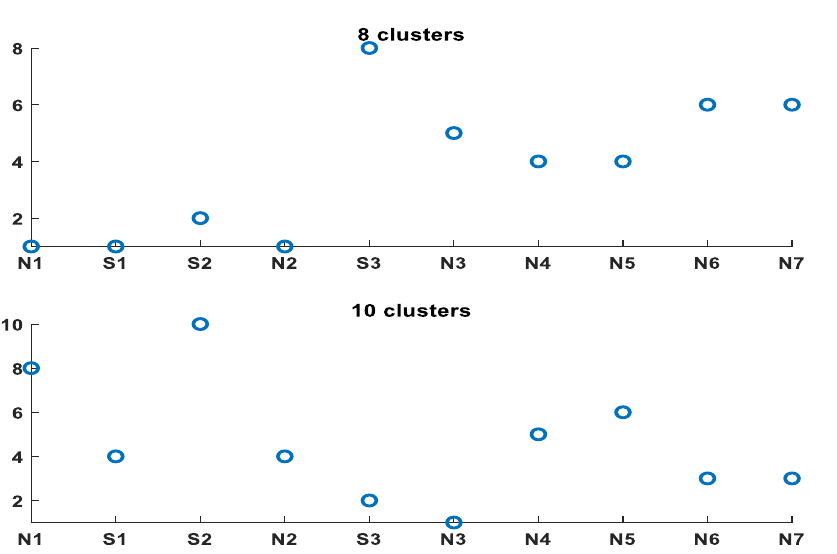
Figure 7. Standard set chosen by Bisgaard [15] mapped to the generated clusters. Table 6. Standard levels chosen by Bisgaard mapped to the generated clusters. Cluster Number in the Cluster Number in the Bisgaard Standard Level Generated 8 Clusters Generated 10 Bisgaard Standard Level